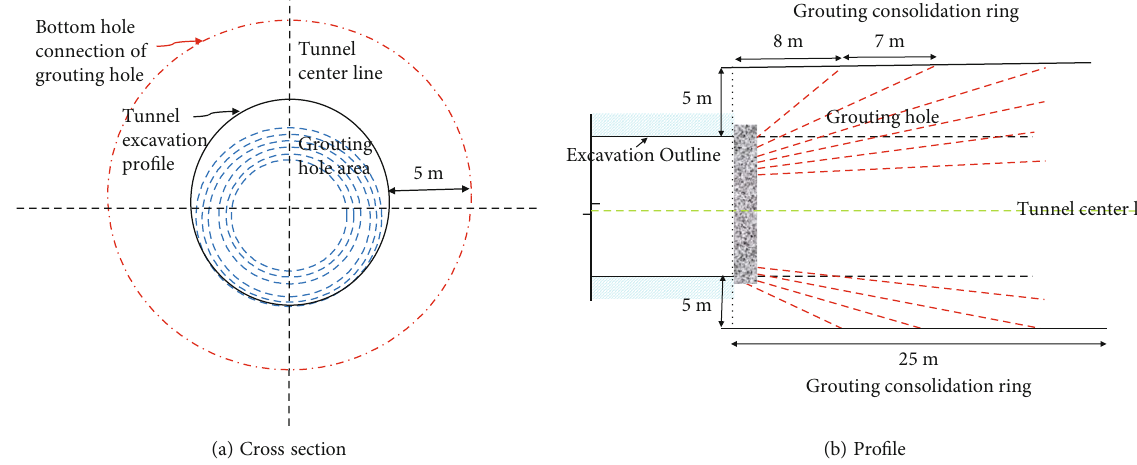
Figure 10: Design drawing of advance curtain